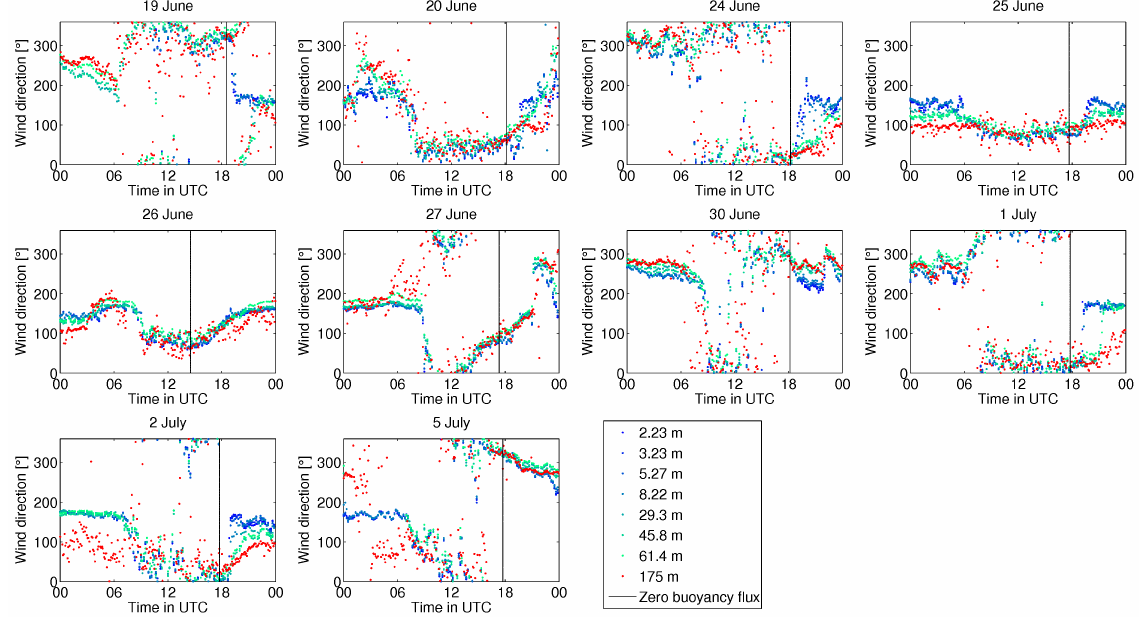
Figure 3. Time series of wind direction for each IOP day, color-coded according to measurement height such that the small-tower measure- ments (2–8m) are shown in bluish colors, high tower measurements (30–60m) in greenish colors and the lowest UHF profiler level (175m) in red. A vertical line is inserted to show the timing of zero-buoyancy flux for each